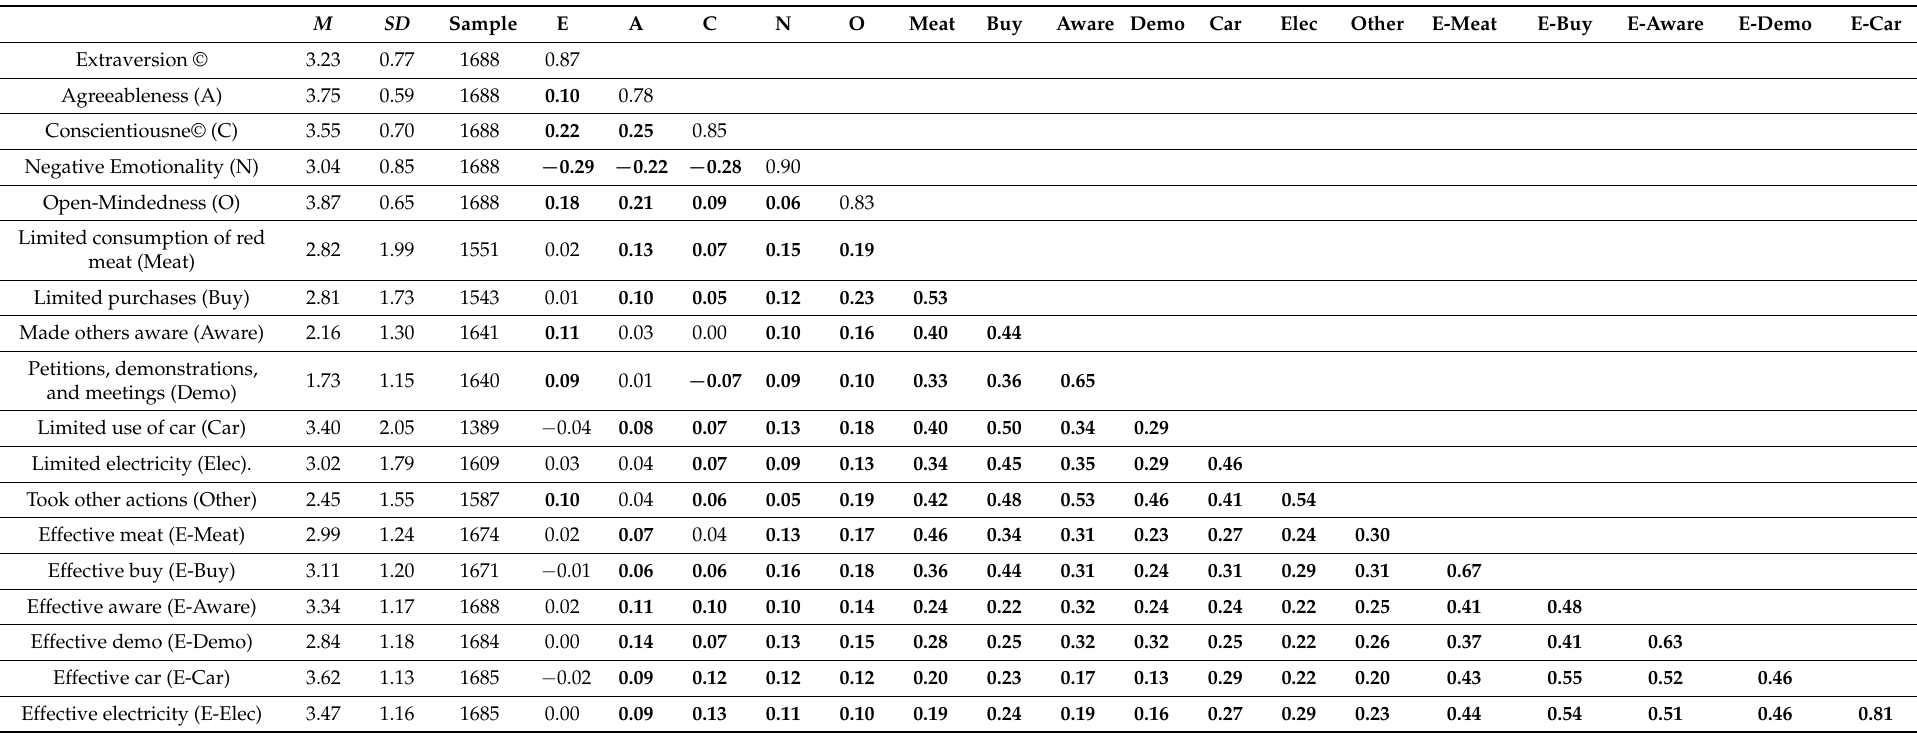
Table 3. Study 2 Descriptive statistics and zero-order correlations between